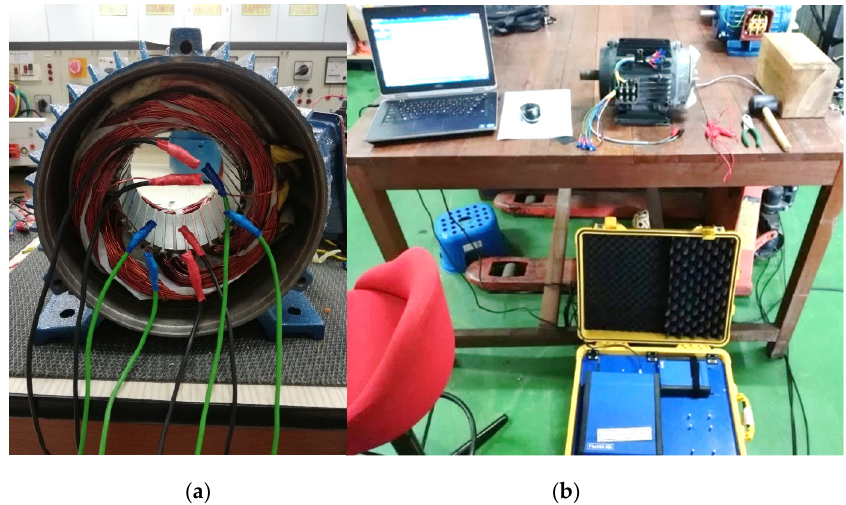
Figure 5: Laboratory setup for IM FRA measurement and faults development ( a ) at fault development ( b ) during the FRA measurement.